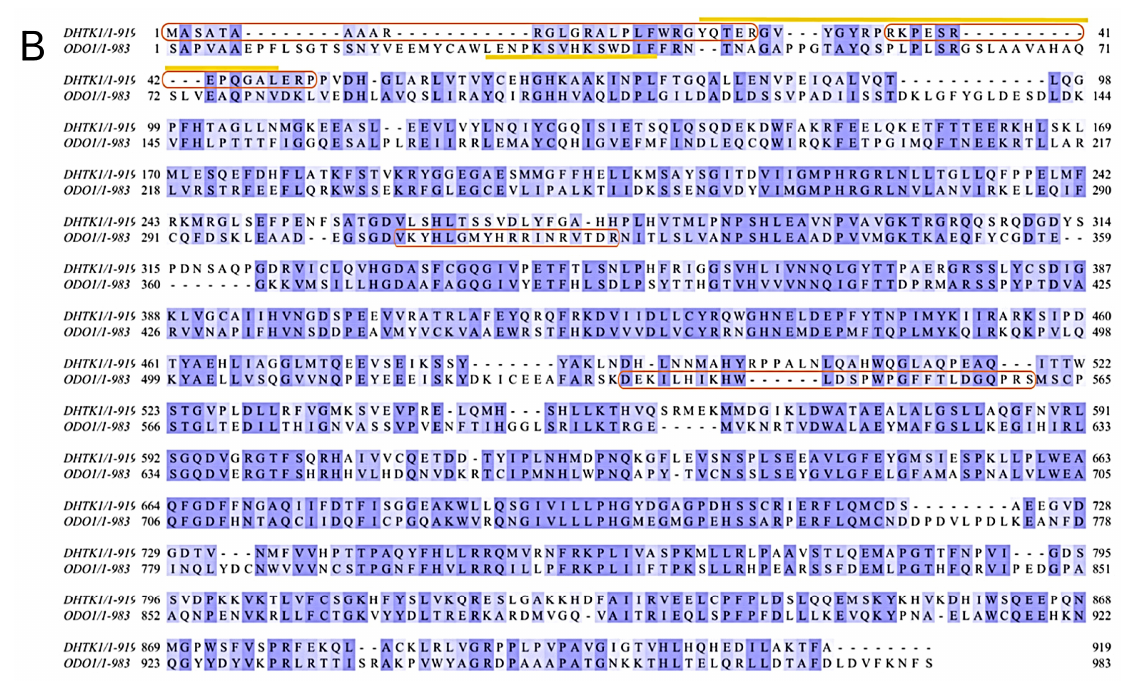
Figure 1. ( A ) Structural alignment of hE1o in blue (PDB ID: 7WGR, ref. [20]) and hE1a in orange (PDB ID: 6U3J, ref. [35]). RMSD on 807 C α pairs: 3.970 Å. ( B ) Pairwise sequence alignment of hE1a and hE1o using the NIH constraint-based multiple sequence alignment tool [36]. The two proteins have 36.3% sequence identity. Residues are colored by identity; dark blue denotes identical residues, whereas light blue represents all other residues. Yellow bars denote N-terminal sequences with retarded deuterium uptake, 26–39 (hE1o) and 24–47 (hE1a). The N-terminal regions of E1s (circled in orange) are not visible in the X-ray or cryo-EM